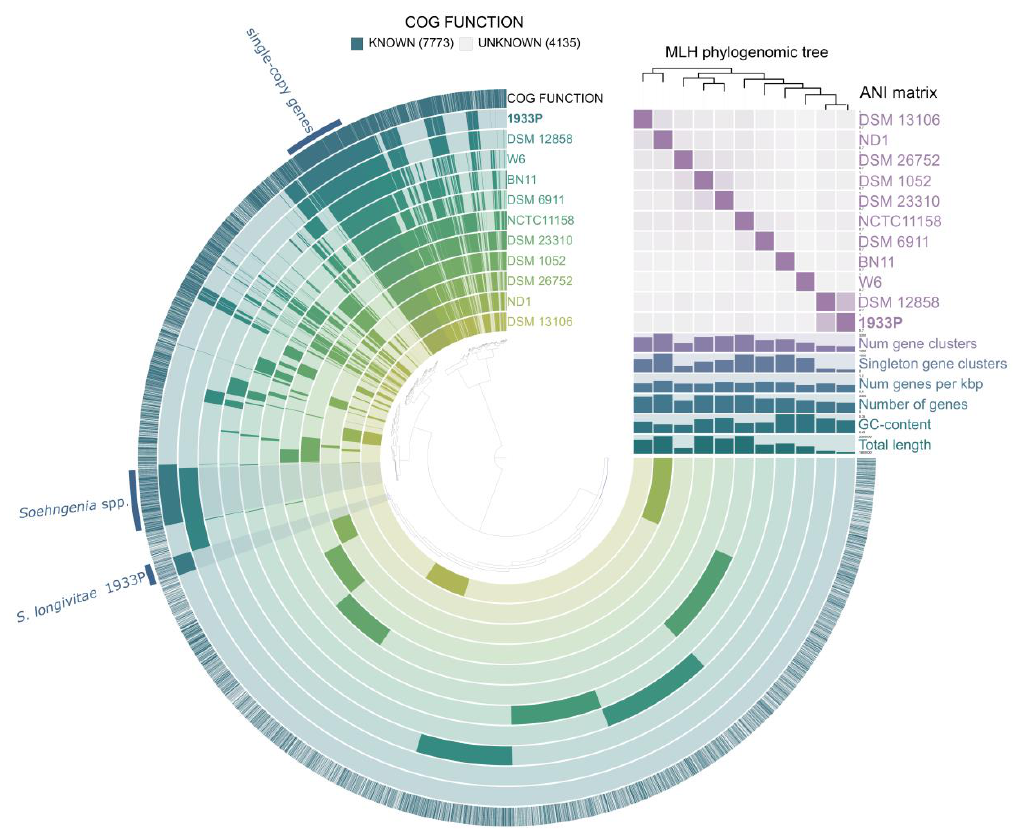
Figure 4. Pangenome analysis of eleven genomes of Tissierellaceae was calculated with Anvi’o version 6.2. The dendrogram at the center represents the relationship between the 11,908 gene clusters (29,926 genes) found in the analyzed genomes. Dark regions in colored circles represent the genes found in that area for each genome. The average nucleotide identity (ANI) heatmap in purple squares varies between 70 and 100%. The phylogenomic tree was reconstructed using the single copy genes.